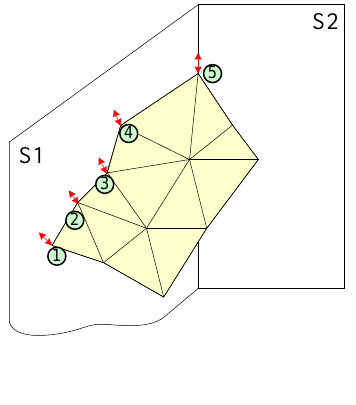
Figure 4. An example of attaching